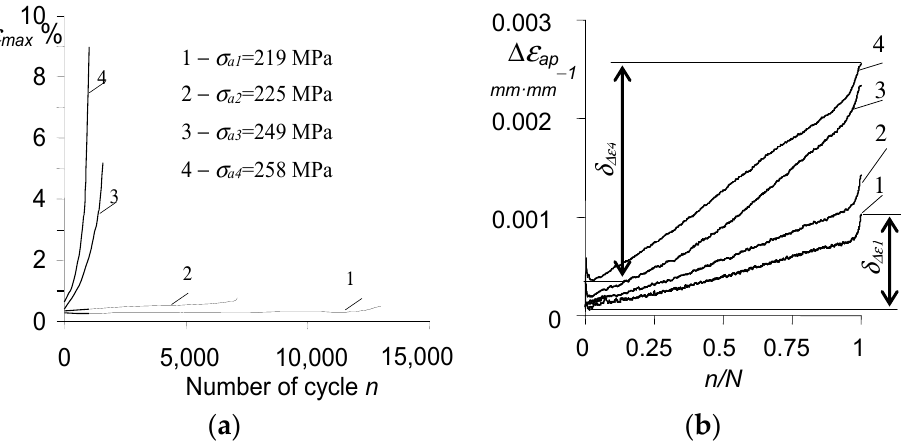
Figure 6. Evolution of: ( a ) maximum strain on cycle; ( b ) plastic strain on cycle ∆ ε ap